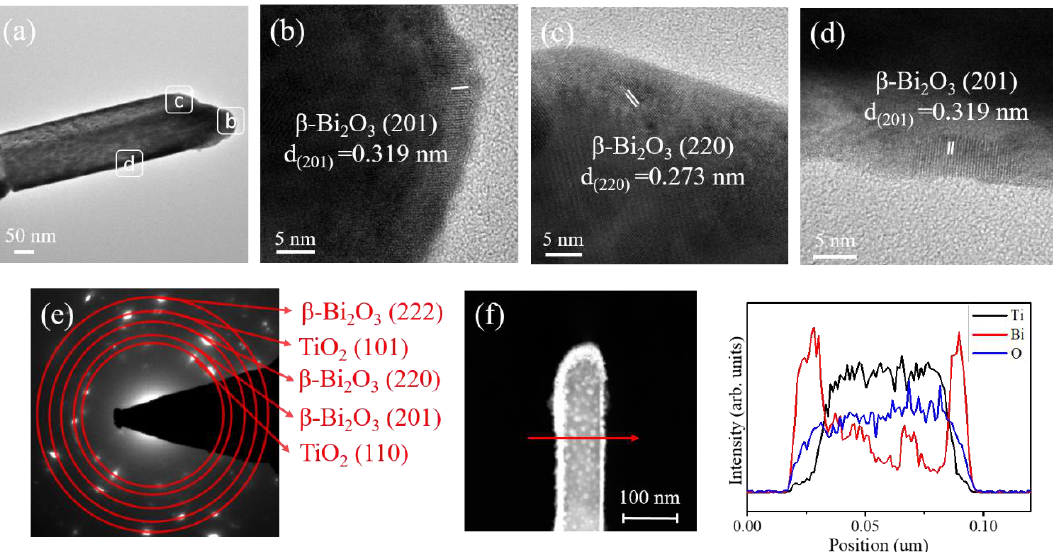
Figure 3. Transmission electron microscopy (TEM) analysis of the TiO 2 / s–Bi 2 O 3 rods: ( a ) Low- magnification TEM image. ( b – d ) High-resolution (HR)TEM images taken from various regions of the composite rod. ( e ) Selected area electron di ff raction (SAED) pattern of several TiO 2 / s–Bi 2 O 3 rods. ( f ) Energy-dispersive X-ray spectroscopy (EDS) line scanning profiles across the composite rod.